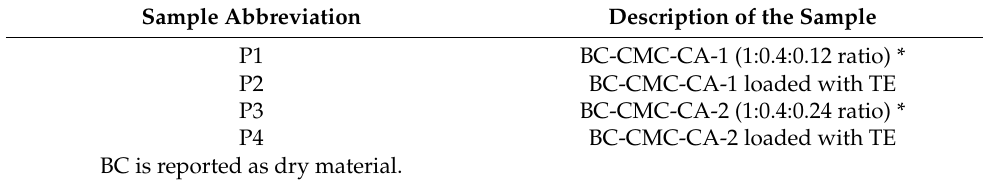
Table 1. Sample symbolic notation.